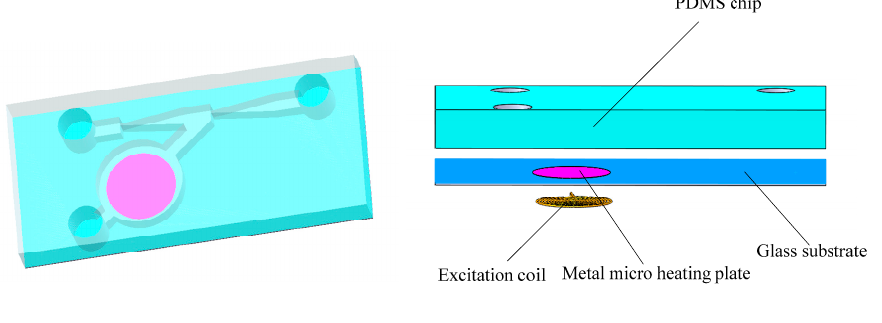
Figure 1. Schematic of the heat source insulation micropump. ( a ) Overall schematic of the micropump; ( b ) Explosion schematic of the micropump.